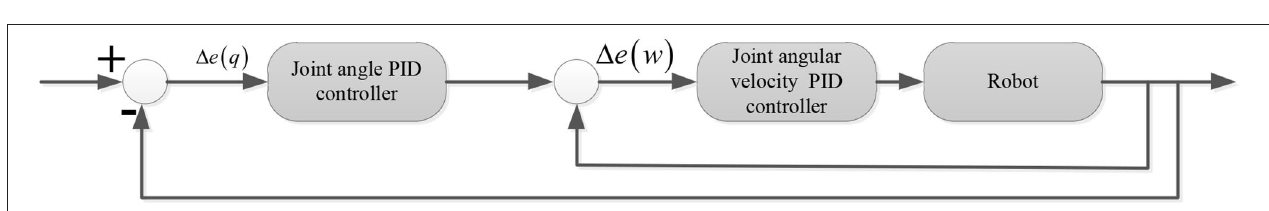
FIGURE 5 | Velocity control of the